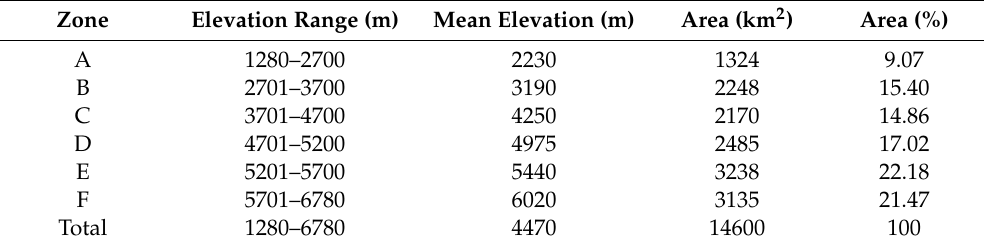
Table 1. Characteristics of elevation zones.